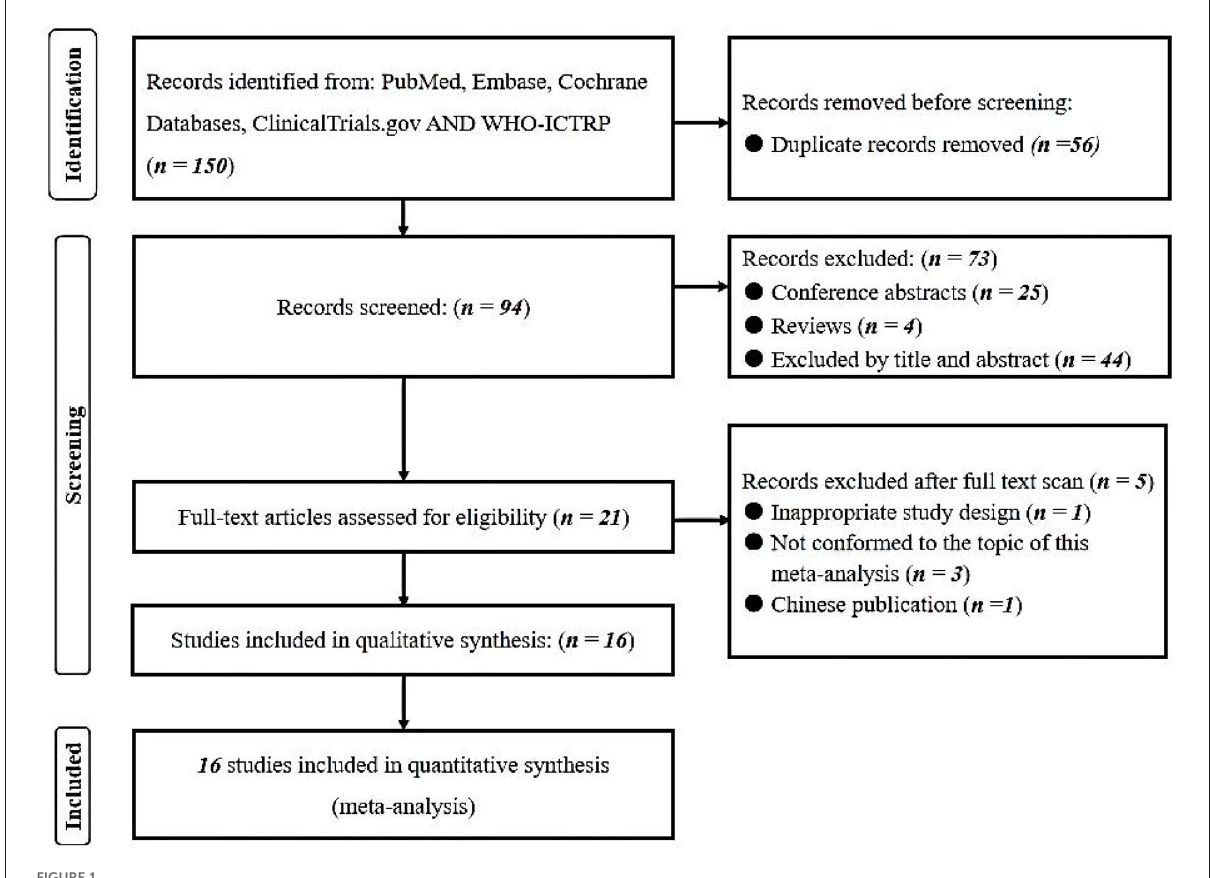
FIGURE1 PRISMA flowchart of included